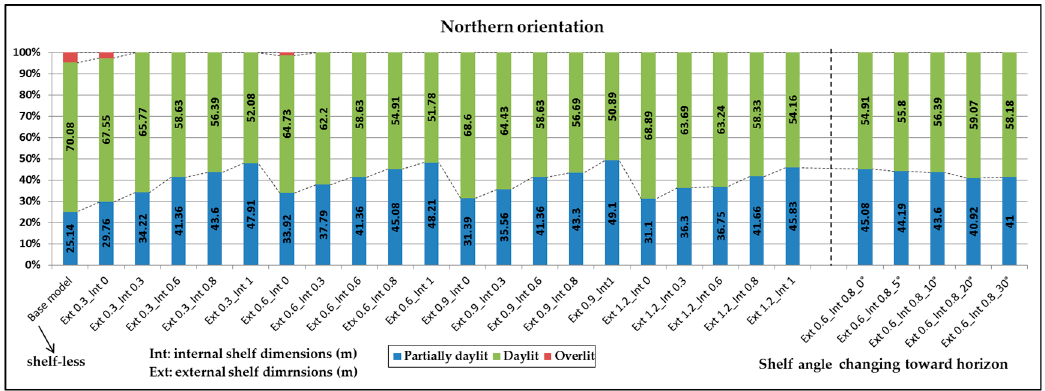
Figure 4. The results of daylight availability analysis for the light shelf in the northern orientation in the three mentioned intervals.